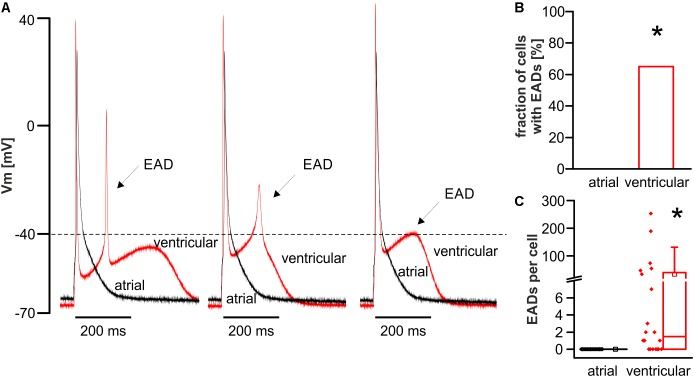
Occurrence of EADs in ventricular but not atrial cardiomyocytes. (A) Representative tracings show various shapes of EADs in ventricular myocytes (red tracing) when the membrane potential of the plateau first falls short of and then exceeds –40 mV threshold. The EAD waveforms ranged between a spike-like shape (left) and a prolonged slew rate (right). No EADs occurred in any atrial myocyte (black tracing). The majority of ventricular cells (B) exhibited multiple EADs (C). ∗p < 0.05 atrial vs. ventricular.